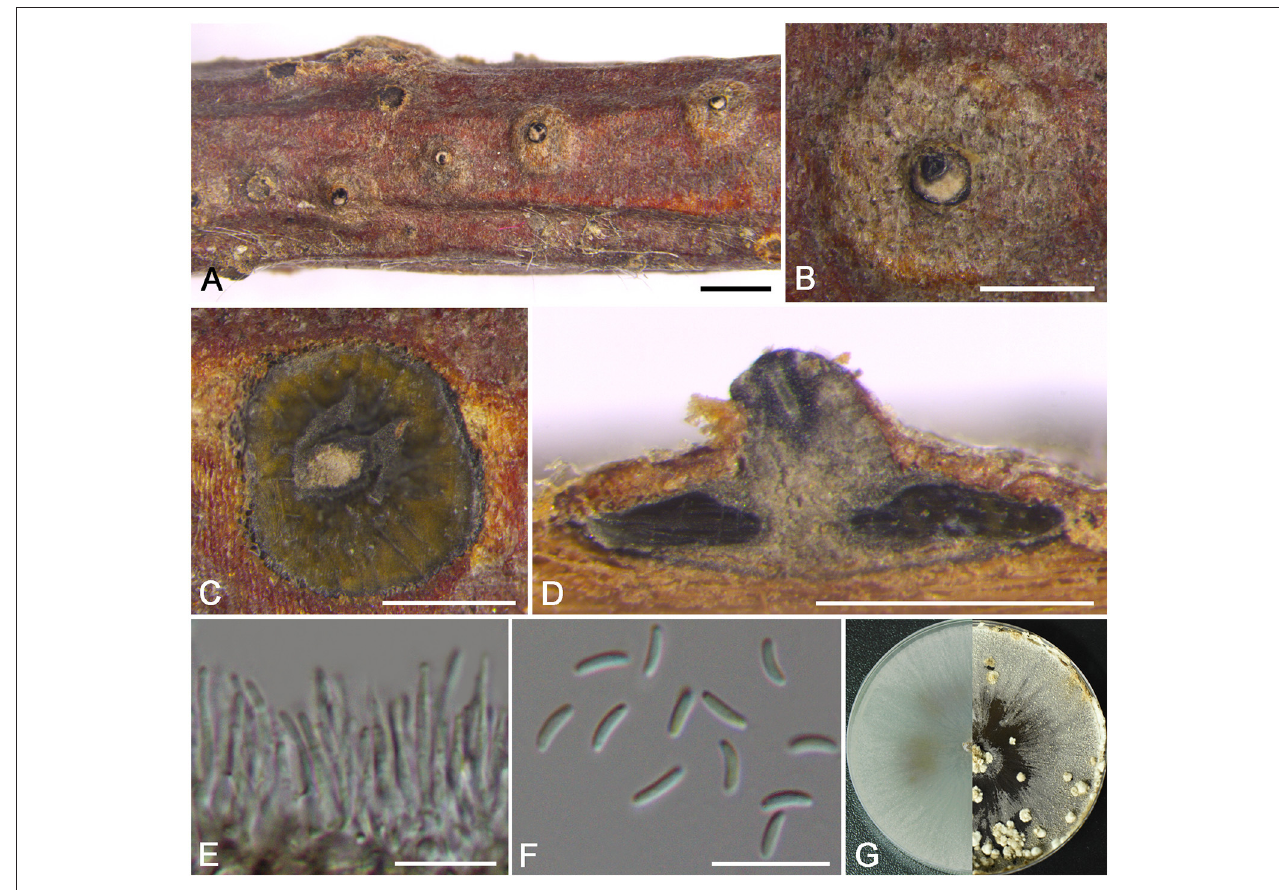
FIGURE 3 | Morphology of Cytospora discostoma (BJFC CF2019802). (A,B) Habit of conidiomata on twig. (C) Transverse section of conidioma. (D) Longitudinal section through conidioma. (E) Conidiophores and conidiogenous cells. (F) Conidia. (G) Colonies on PDA at 3 days (left) and 30 days (right). Bars: (A) = 1mm; (B–D) = 500 µ m; (E,F) = 10 µ